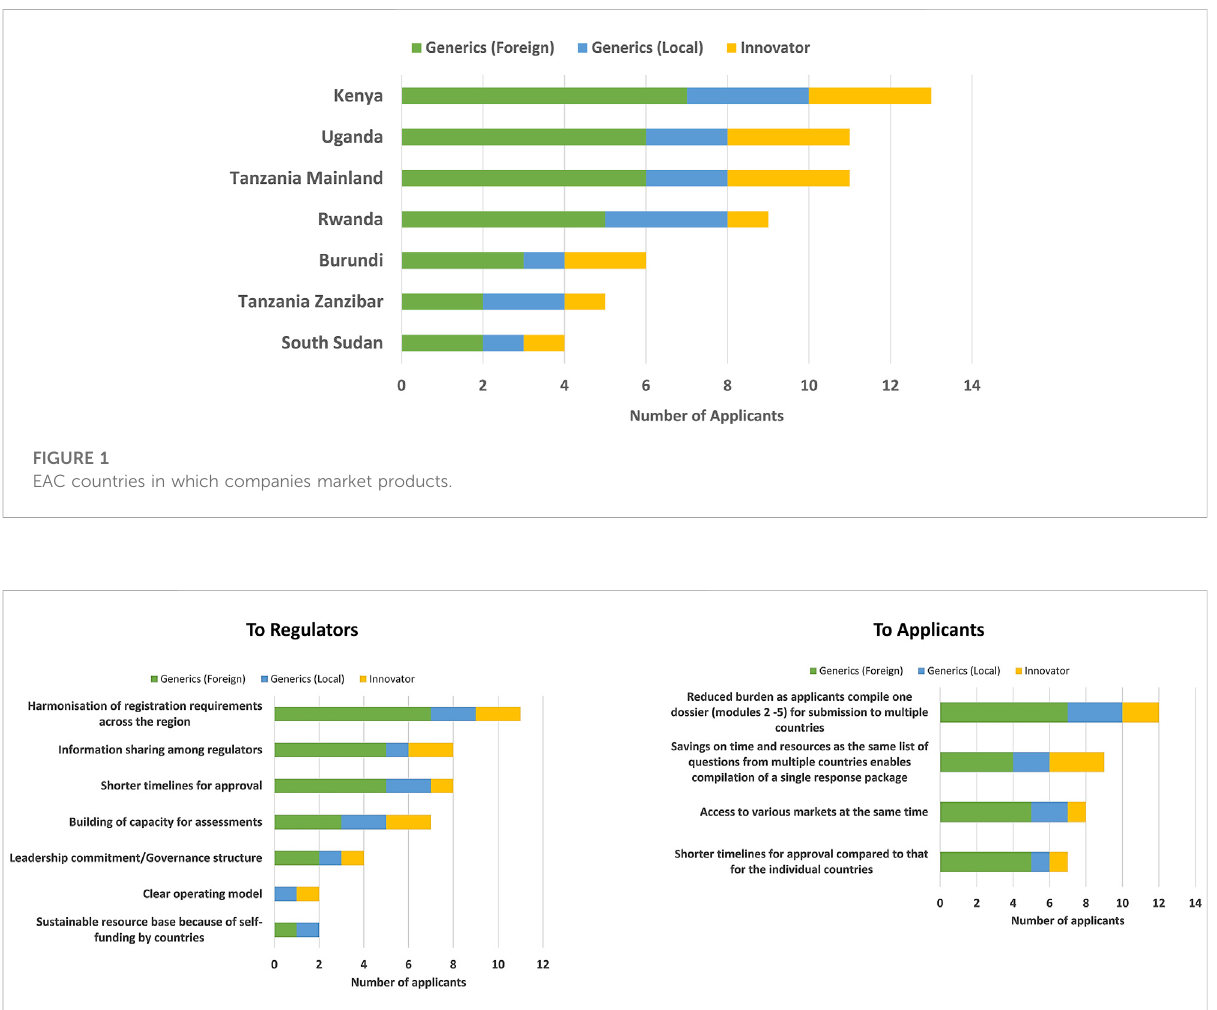
FIGURE 2 Bene fi ts of the EAC-MRH